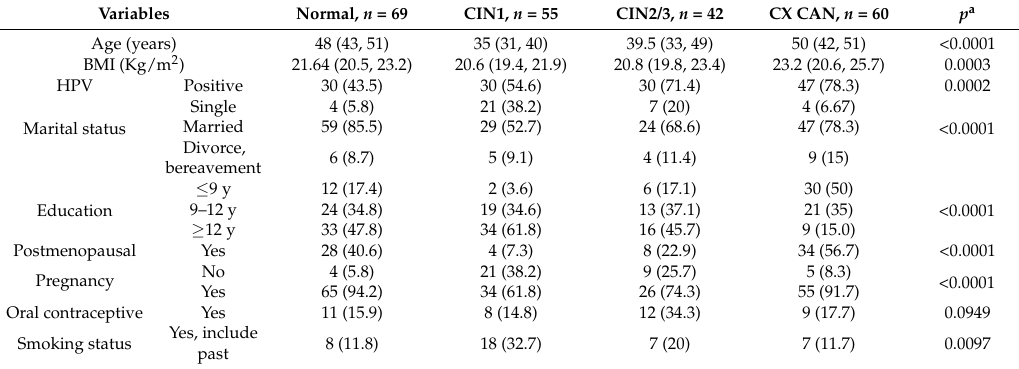
Table 1. General characteristics of study